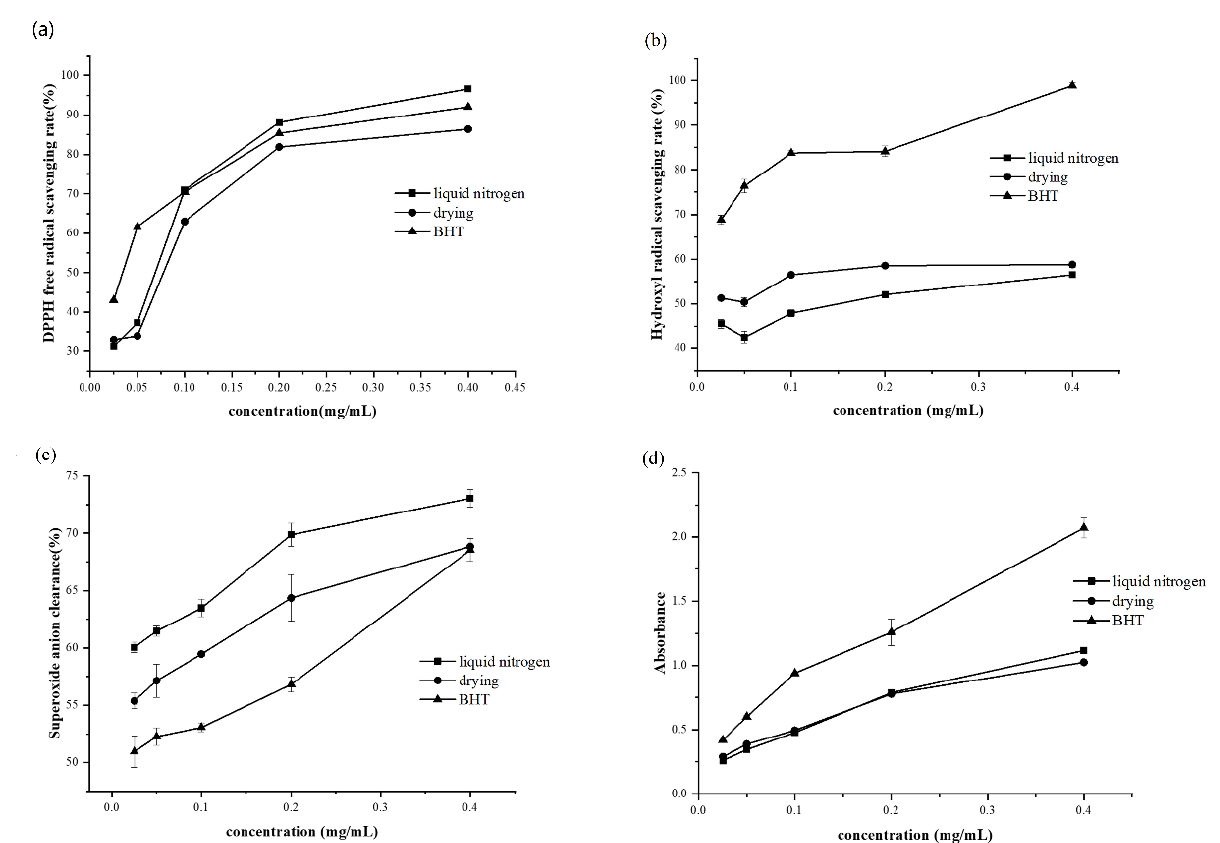
Figure 3. Antioxidant activity test result. ( a ): DPPH free radical scavenging test results. ( b ): Hydroxyl radical scavenging test results. ( c ): Results of superoxide anion radical scavenging test. ( d ): Fe 3+ reduction experiments.